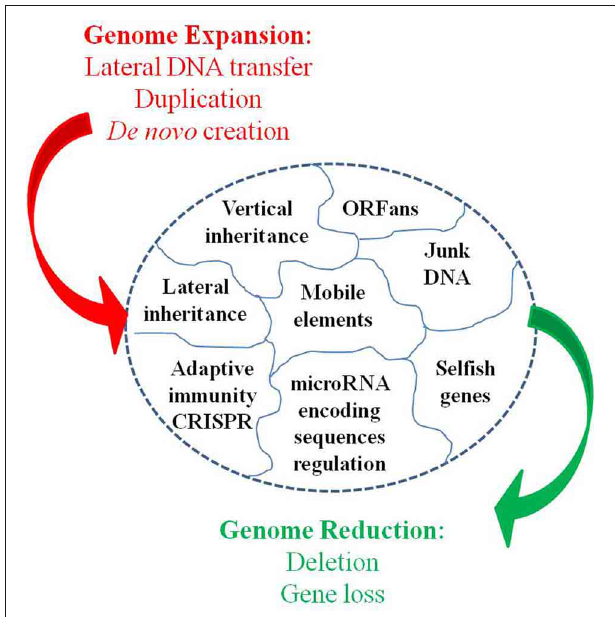
FIGURE 3 | Dynamic entity of the bacterial